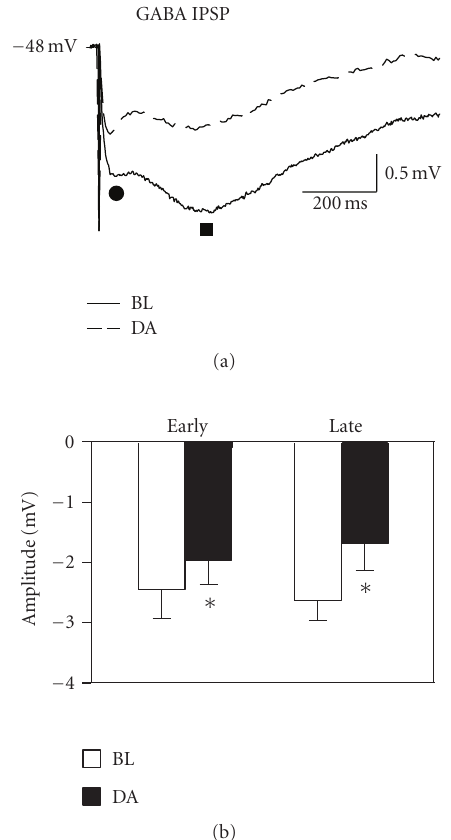
Figure 5: Dopamine suppresses both the fast and slow components of the mixed monosynaptic IPSP in fan cells. (a) GABA-mediated IPSPs were isolated pharmacologically with ionotropic glutamate receptor blockers and recorded at membrane potentials just below action potential threshold. Both the early (circle) and late (square) components of the biphasic IPSP were suppressed by 50 μ M dopamine (DA). (b) Group data reflect a significant suppression of both the early and late